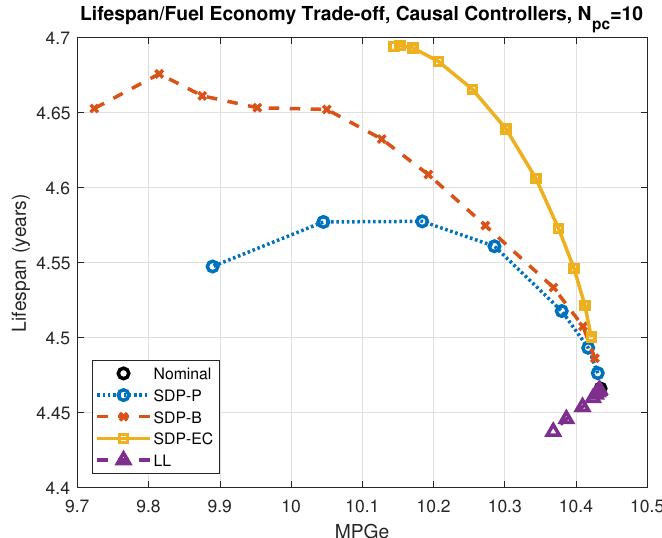
Figure 7. Comparison of energy consumption and battery aging for the four causal control methods, N pc = 10.